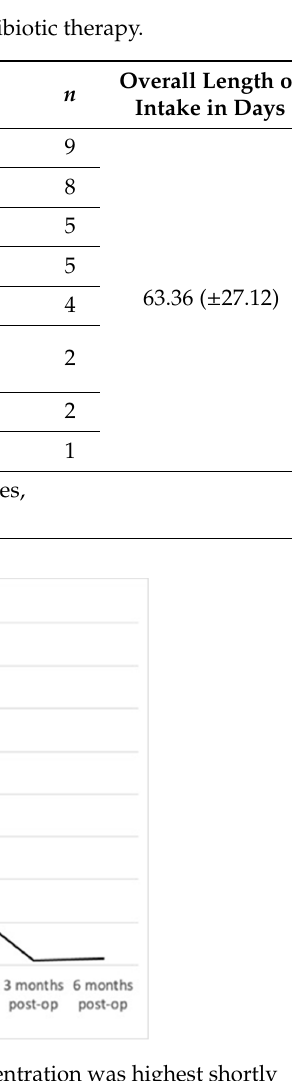
Table 2. Pain medication at the time of discharge from the hospital.